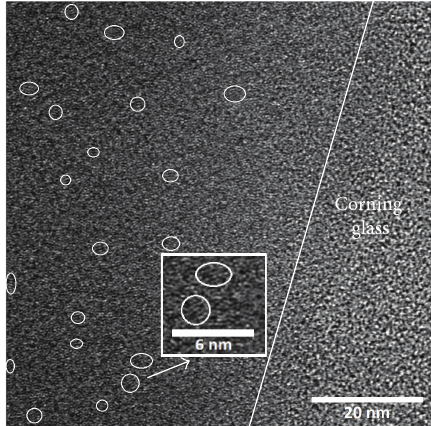
Figure 4: HRTEM cross section of a pm-Si 𝑥 Ge 𝑦 :H film, where the presence of nanocrystals of sizes in the range of 2 nm-3nm is observed. The inset shows an amplified image of 2 nanocrystals.